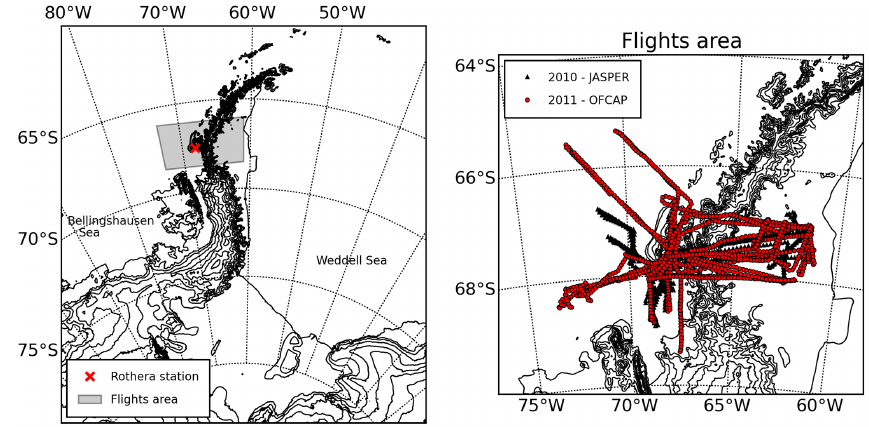
Figure 1. (Left panel) The Antarctic Peninsula and flight area in context, with the BAS Rothera station indicated (red cross). On the penin- sula’s eastern side is the ice-covered Weddell Sea. Solid lines indicate topographical features as well as ice shelves’ boundaries. (Right panel) Close-up on the flight area showing the flight tracks of both campaigns of interest with black triangles (February 2010) and red circles (January 2011). Topography derived by Fretwell et al.